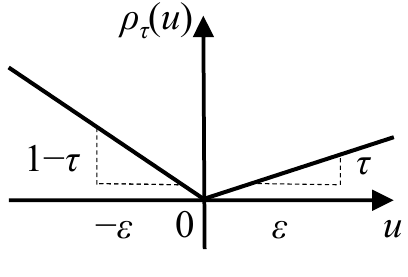
Figure 6. Pinball loss